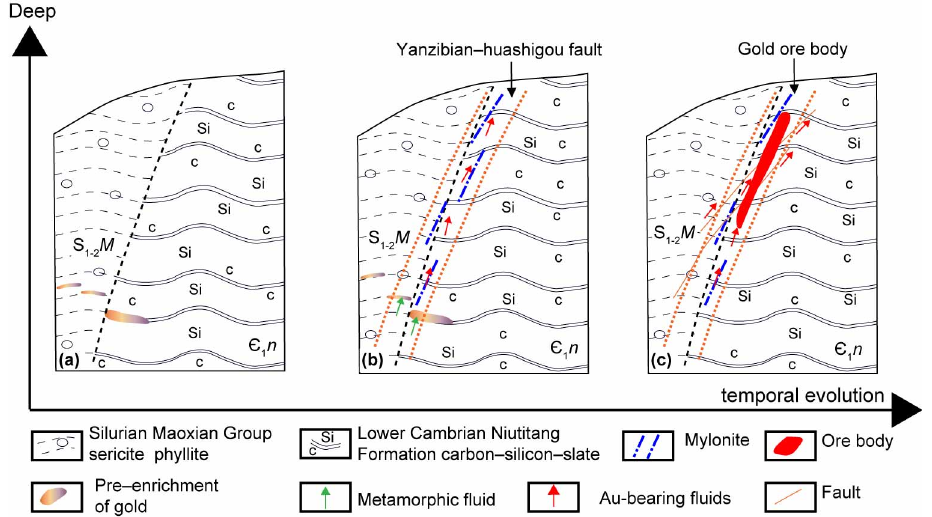
Figure 9. Superimposition model for ore mineralization in the brittle-ductile shear zone in the Xin- jiazui gold deposit. ( a ) gold pre-enrichment occurs during the deposition and di-agenesis of the original surrounding rock; ( b ) deep metamorphic fluids move upward along the ductile–brittle shear fault and lead to the element Au being remobilized, forming Au-bearing tectonic-metamor- phic hydrothermal fluids; ( c ): the superposition of brittle fractures in the later stage leads to the further enrichment of gold and other metal-forming materials, and high-grade gold ore is finally formed at the superposition of strong ductile deformation and brittle fractures.